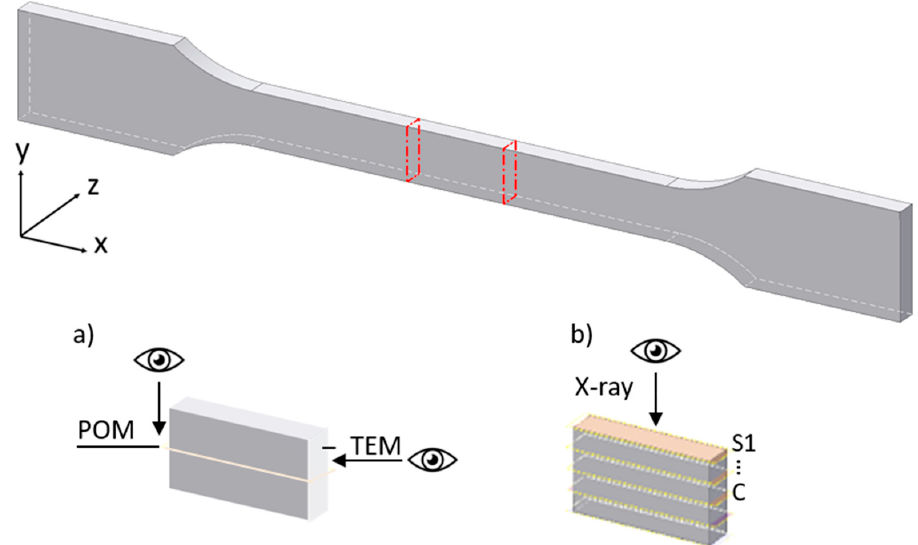
Figure 1. Tensile test bar type 1A. Preparation scheme: ( a ) for polarized-light optical microscopy (POM) and transmission electron microscopy (TEM), ( b ) for X-ray scattering.